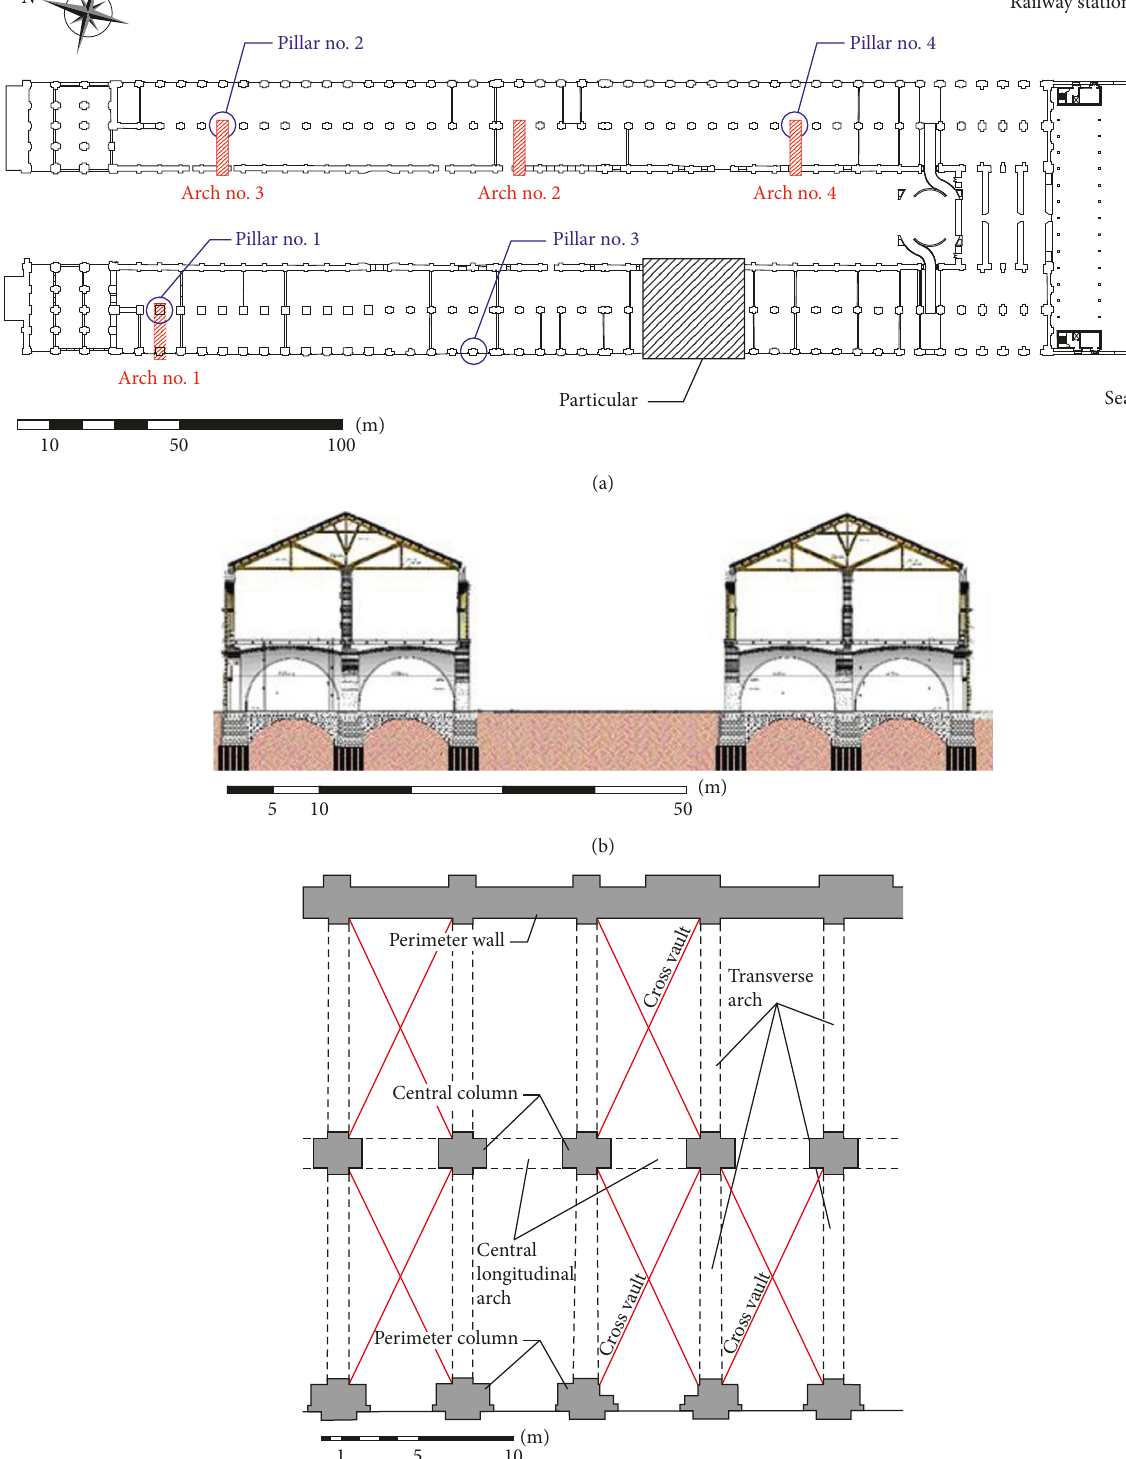
Figure 2: Geometrical survey of the building: (a) plan of the ground floor; (b) typical transversal section; (c) particular of the bearing structural